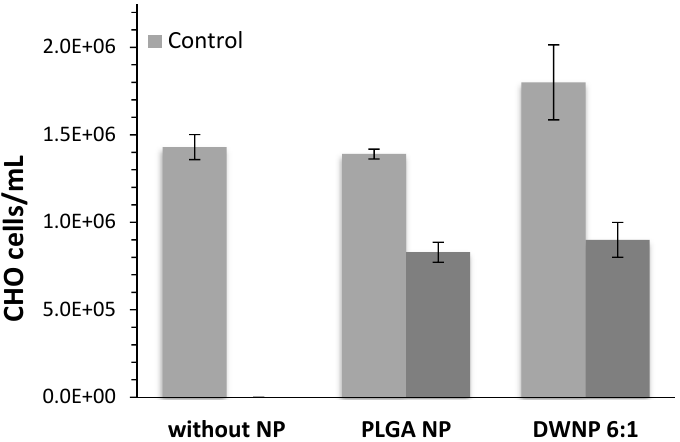
Figure 6. Absolute number of CHO cells in the presence of 1 mg/mL of unloaded or doxorubicin- loaded PLGA NP and DWNPs 6:1, ( n = 3).